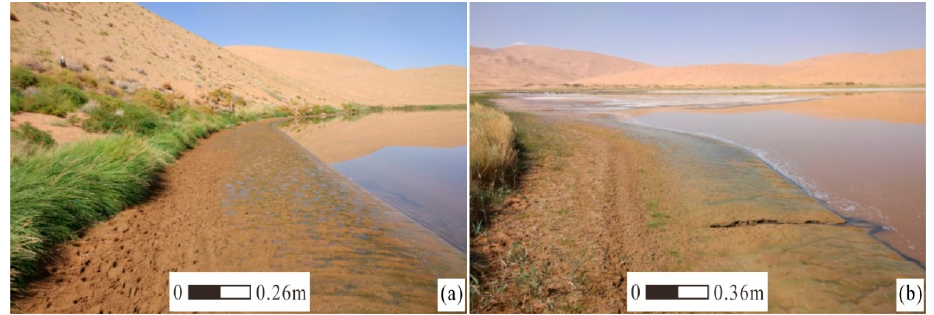
Figure 5. Groundwater overflow zone between megadune and lake. ( a ), Zhalate Lake; ( b ), western Badan Lake.